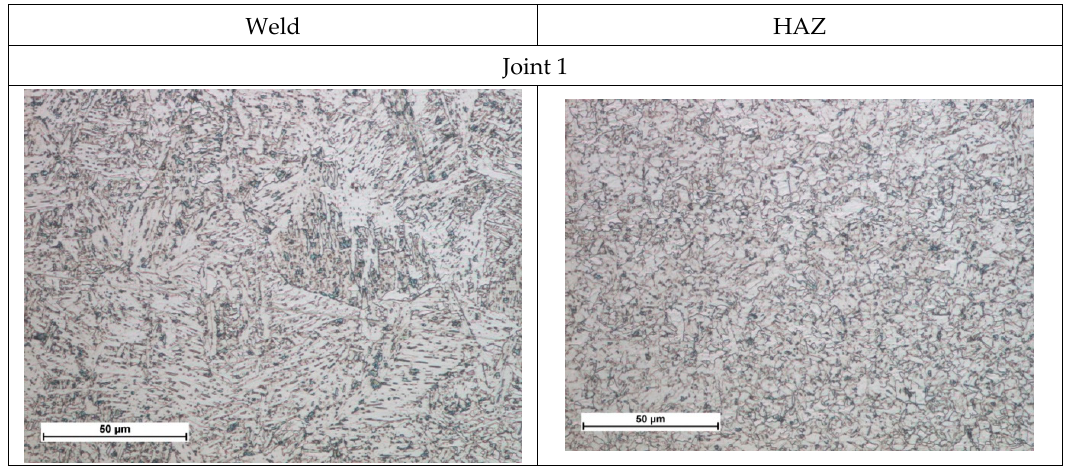
Figure 9. View of the macrostructures of the laser and MAG S700MC steel welded joints.